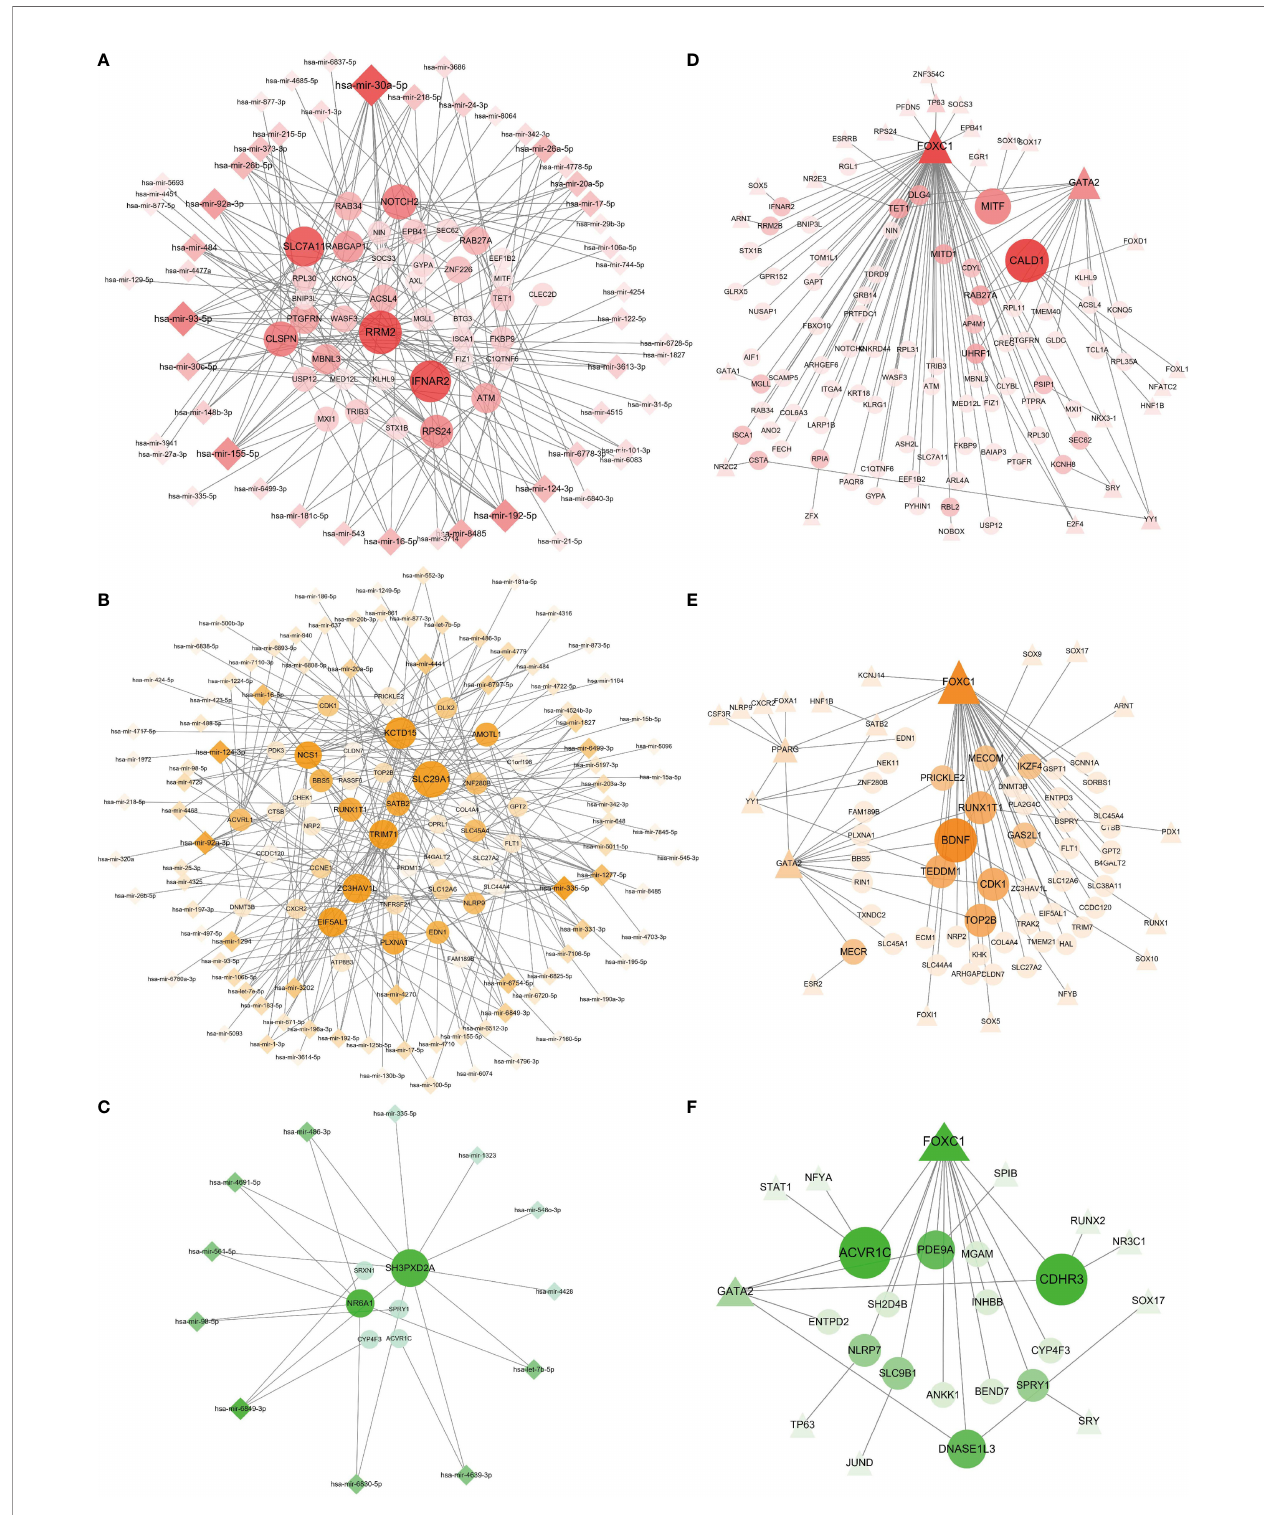
FIGURE 6 | Regulatory gene networks of COVID-19 with psychiatric disorders. Panels (A – C) designate the DEG – miRNA networks of COVID-19 with BD, SZ, and LOD, respectively. Circles designate DEGs and diamonds designate miRNAs. The results of the DEG – TF networks of (D) BD – COVID-19, (E) SZ – COVID-19, and (F) LOD – COVID-19. Circles illustrate DEGs, and triangles represent TFs. Overexpressed DEGs, miRNAs, and TFs are designated by larger size and darker